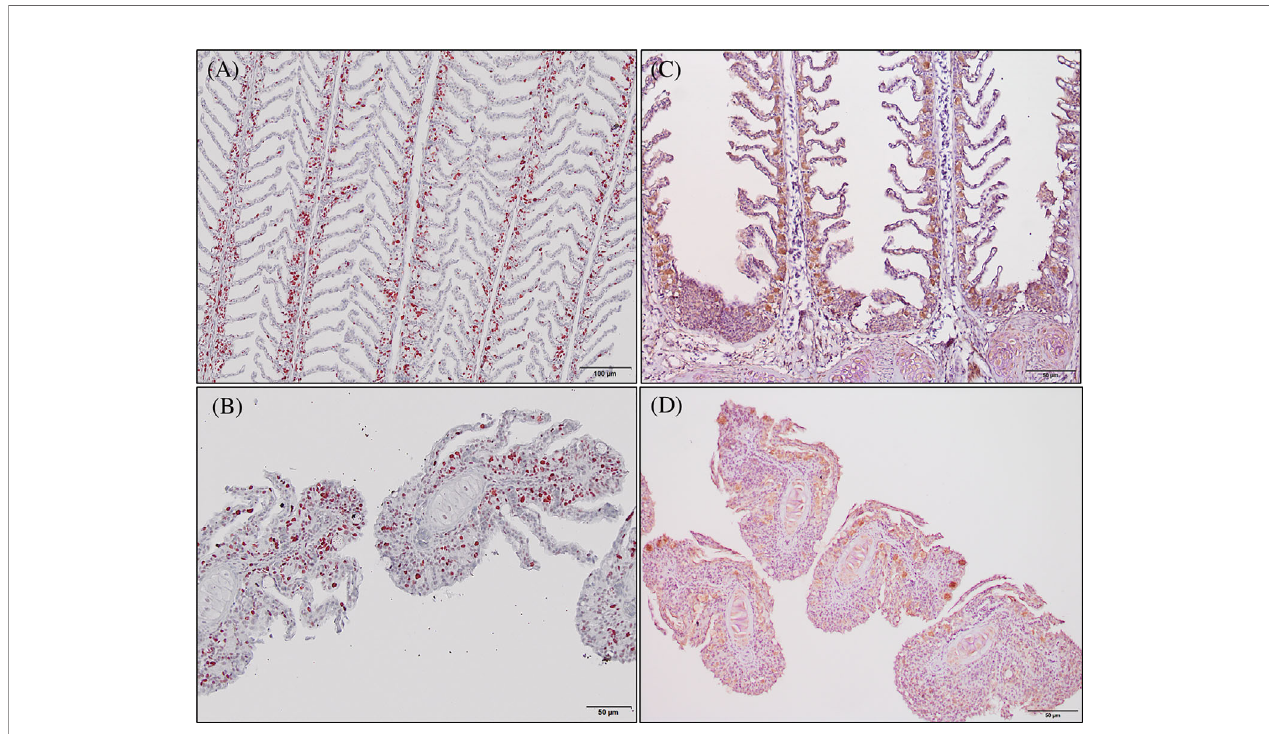
FIGURE 6 | Photomicrographs of the gill immunoreactivity with the antihuman anti-PCNA and anti-iNOS-2 antibodies at the end of the feeding trial. Immunoreactivity to anti-PCNA and anti-iNOS-2 was detected in all fi sh gills sections studied. European sea bass gill immunoreactivity to anti-PNCA antibody ( A , B ; Bars = 100 and